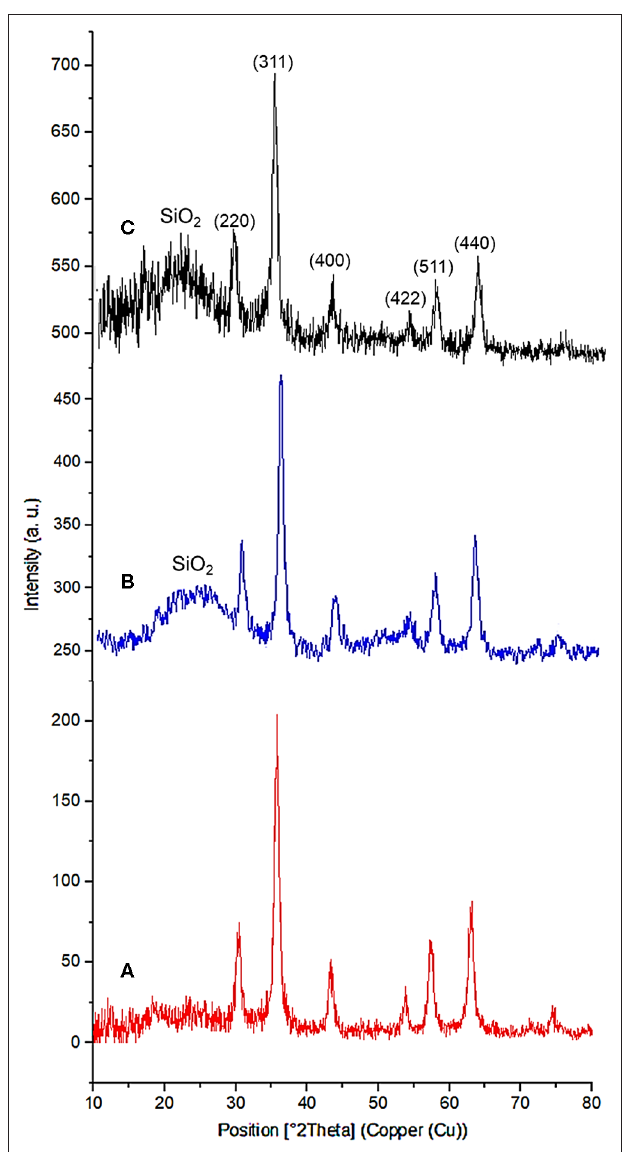
FIGURE 3 | PXRD patterns of the (A) Fe 3 O 4 , (B) Fe 3 O 4 @OS, and (C) Fe 3 O 4 @OS-SO 3 H nanomaterials.